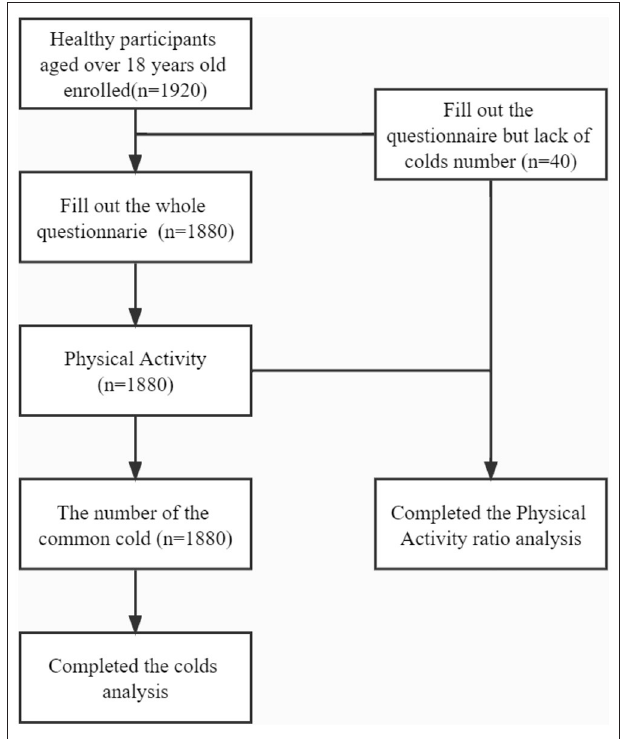
FIGURE 1 | CONSORT diagram of the survey